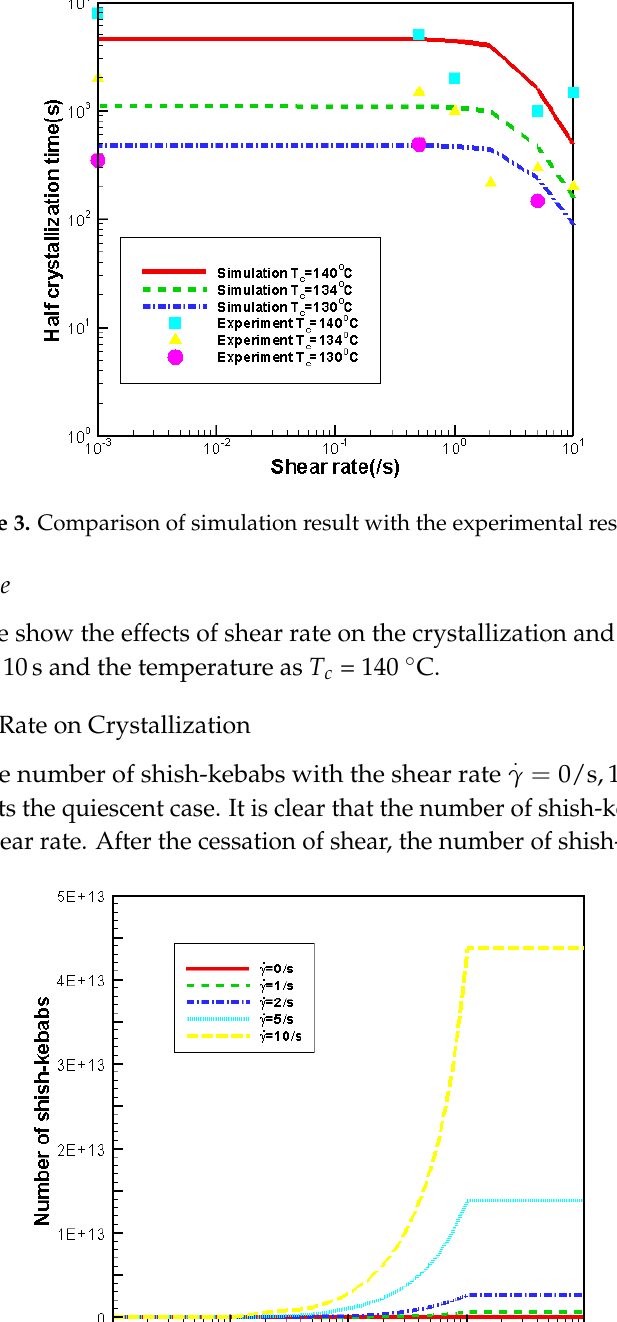
9 of 16 Figure 2. Comparison of simulation result with Avrami model.